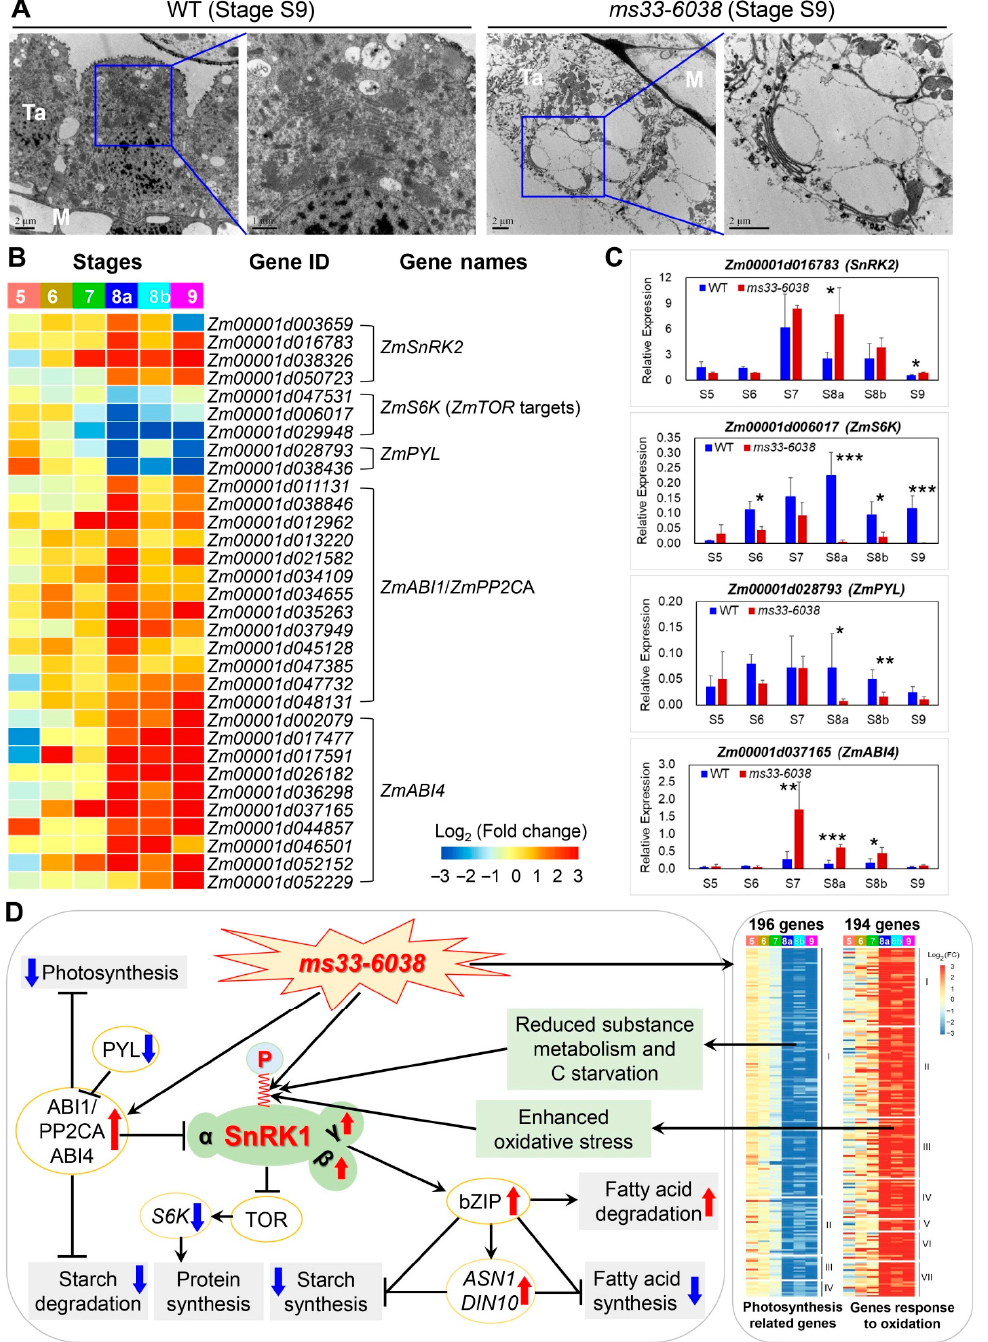
Figure 7. Premature and excessive tapetal autophagy and the underlying mechanism of metabolic reprogramming in ms33-6038 anthers. ( A ) Premature and excessive tapetal autophagy in ms33-6038 anthers. ( B ) Expressions changes of genes involved in metabolic reprogramming related to SnRK1, TOR, PP2CA pathways, and oxidative stress responses in the ms33-6038 anther transcriptomes. ( C ) Validation of expression change patterns of four representative genes related to metabolic repro- gramming by qPCR analysis. * p < 0.05, ** p < 0.01, *** p < 0.001, Student’s t -test. ( D ) The potential molecular mechanism of metabolic reprogramming in ms33-6038